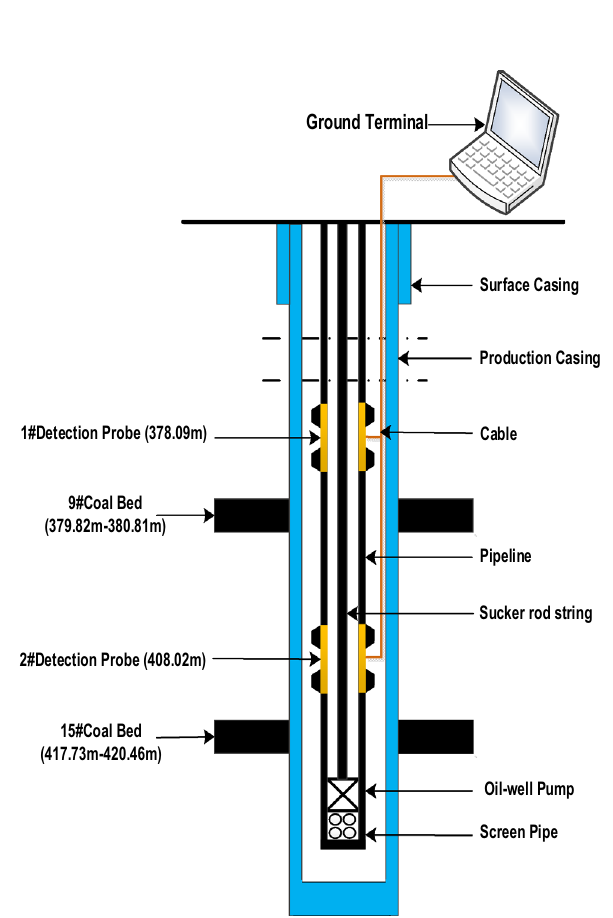
Fig. 7 Detection probe installation position